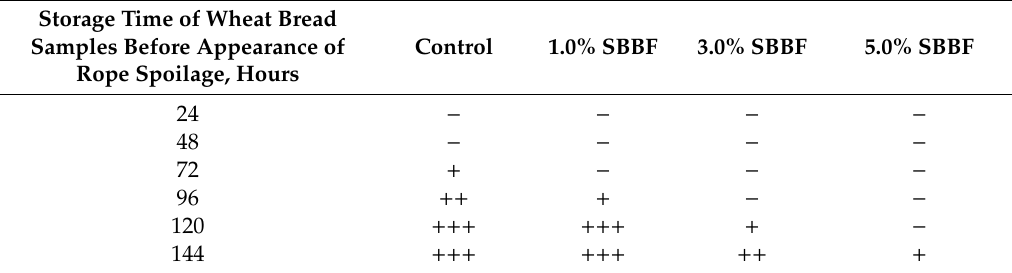
Table 5. The influence of sea buckthorn berry flour on the development of rope spoilage during wheat bread